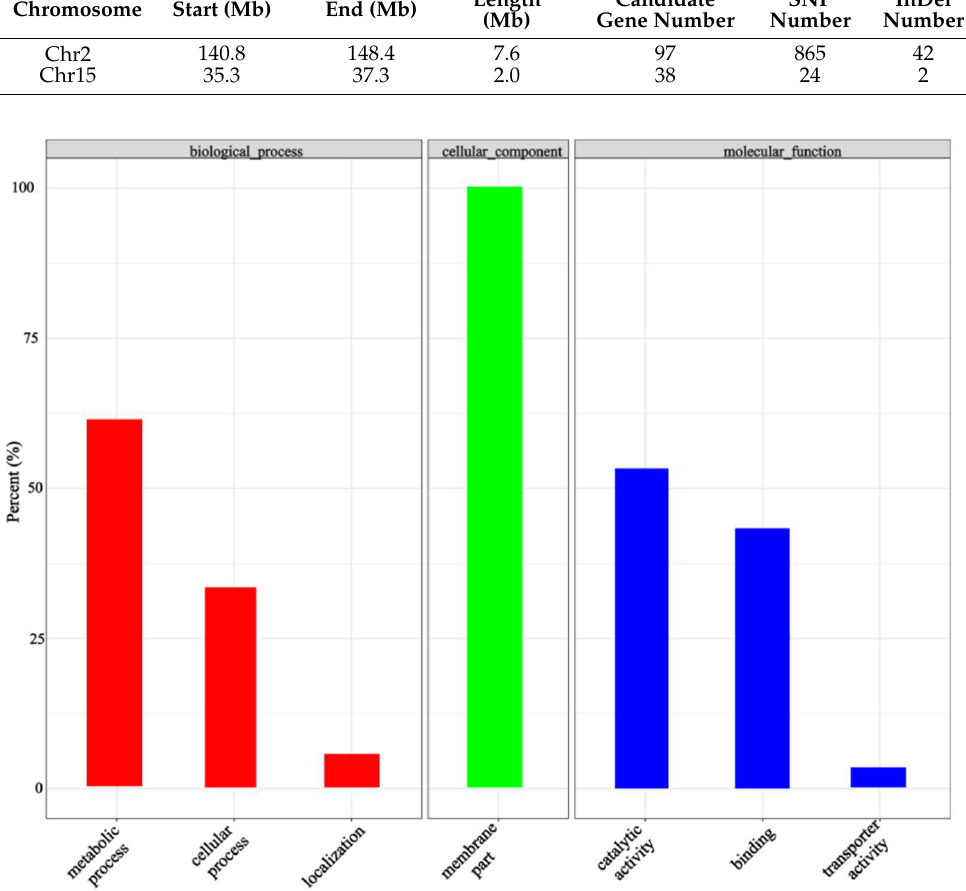
Figure 6. The enriched GO terms in the molecular function, cellular component, and biological process categories.